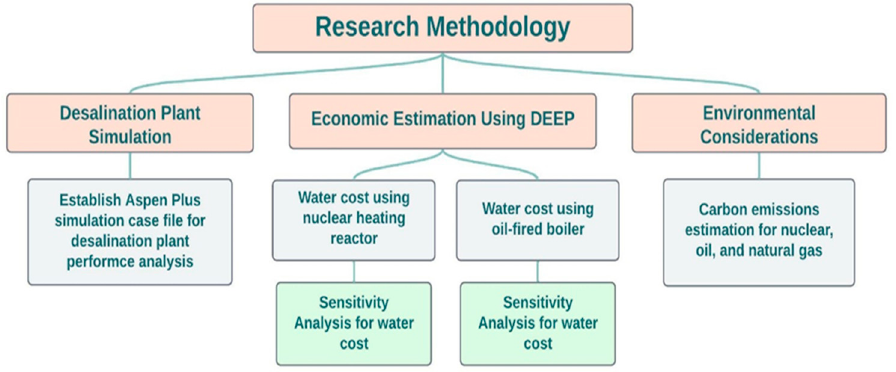
Figure 1. Schematic diagram of the research methodology.